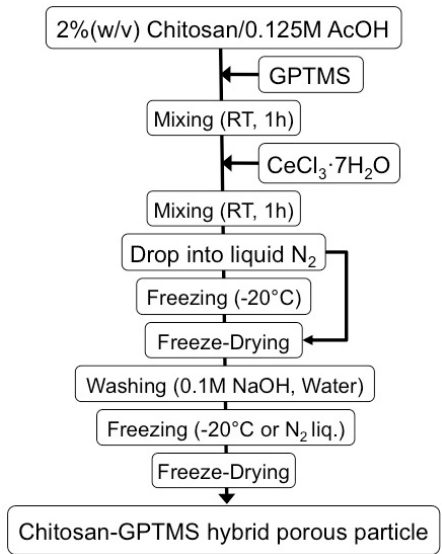
Figure 1. Preparation scheme of the chitosan − siloxane hybrid spheres.